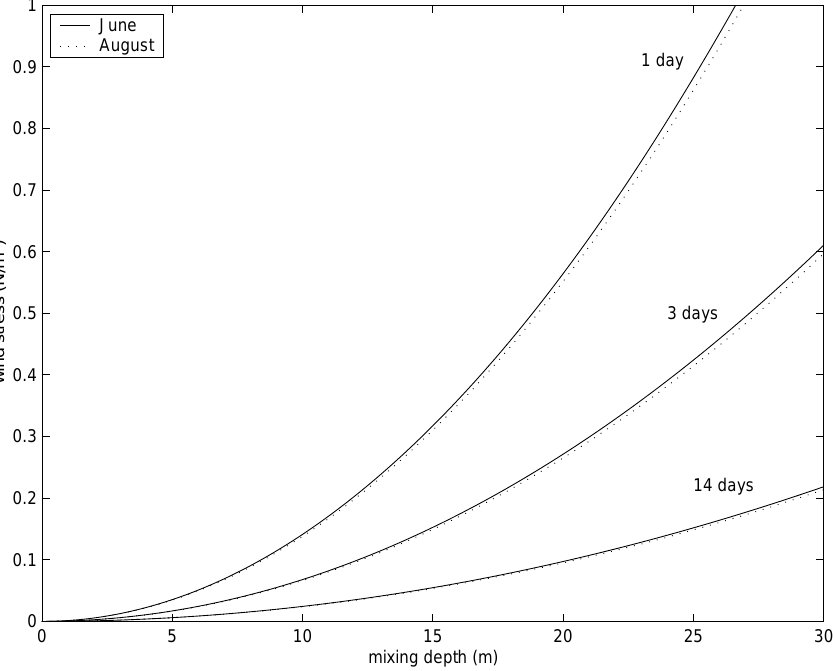
Fig. 7. Relationship between the wind stress and the mixing depth under different stratification conditions and different durations of the wind